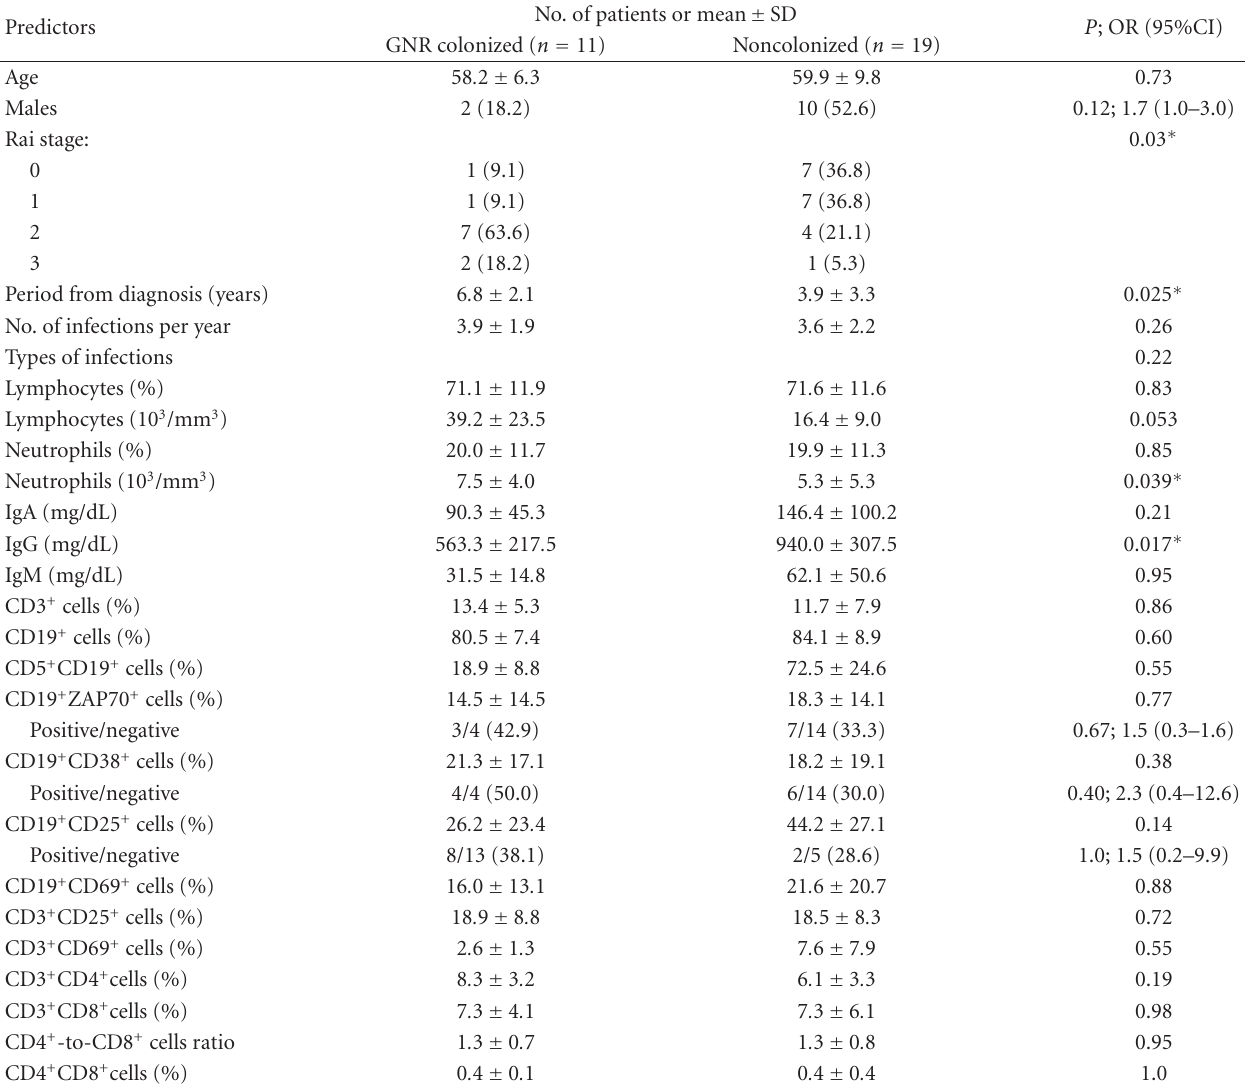
Table 3: The association between Gram-negative rods colonization and selected demographic, clinical or laboratory parameters in CLL patients.